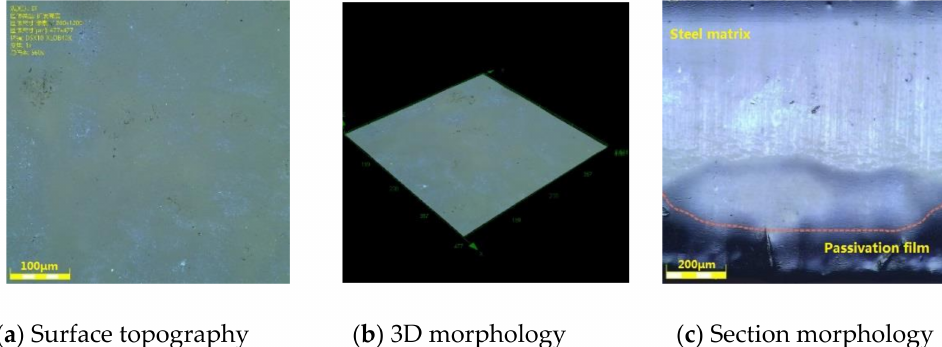
Figure 12. Morphology of rusty steel plate coated with composite-based paint film with the RC-D to VDC-MA ratio of 10 wt.% ( ×